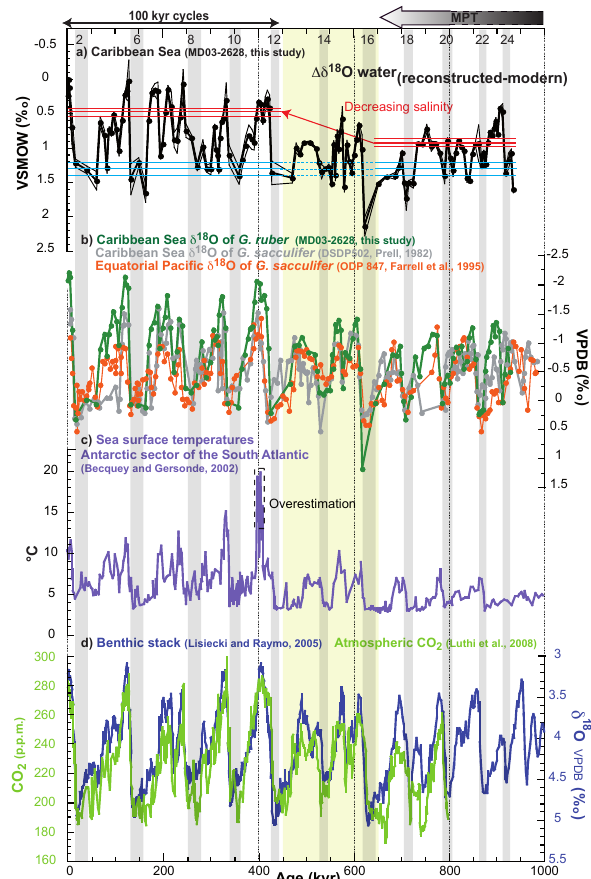
Fig. 7. (a) Mean variations for the δ 18 O of seawater relative to mod- ern values (noticed 1δ 18 O) at the core MD03-2628 location, as a proxy for past sea-surface salinities (SSS) (the black bold line and full circles, the thin lines indicate the standard deviation). The light blue bold line represents the average glacial values for the 950–650 and the 450–0ka time interval. The thin blue lines are the error at 1 σ m . The red bold lines represent, for each time interval (950–650 and 450–0ka), the associated mean 1δ 18 O value for interglacial stages (thin red lines exhibit the error given by 1 σ m ) . The red arrow indicates the shift in past-SSS values for interglacial stages occuring after 650ka. (b) A comparison between the planktonic δ 18 O records of core MD03-2628 (green curve and dots, this study) with the δ 18 O of G. sacculifer records from the Southern Caribbean Sea (DSDP 502, Fig. 1a, Prell, 1982, gray curve and dots), and the Equatorial Pacific (ODP 847, Fig. 1a, Farell et al., 1995, orange curve and dots). (c) The sea-surface temperature record from the Antarctic sector of the South Atlantic (core ODP 1090, Becquey and Gersonde, 2002). (d) The global benthic δ 18 O record from Lisiecki and Raymo (2005) in dark blue, and past atmospheric CO 2 concentrations in light green (Luthi et al., 2008). Light gray bars, even numbers, and yellow area are the same as in Fig.